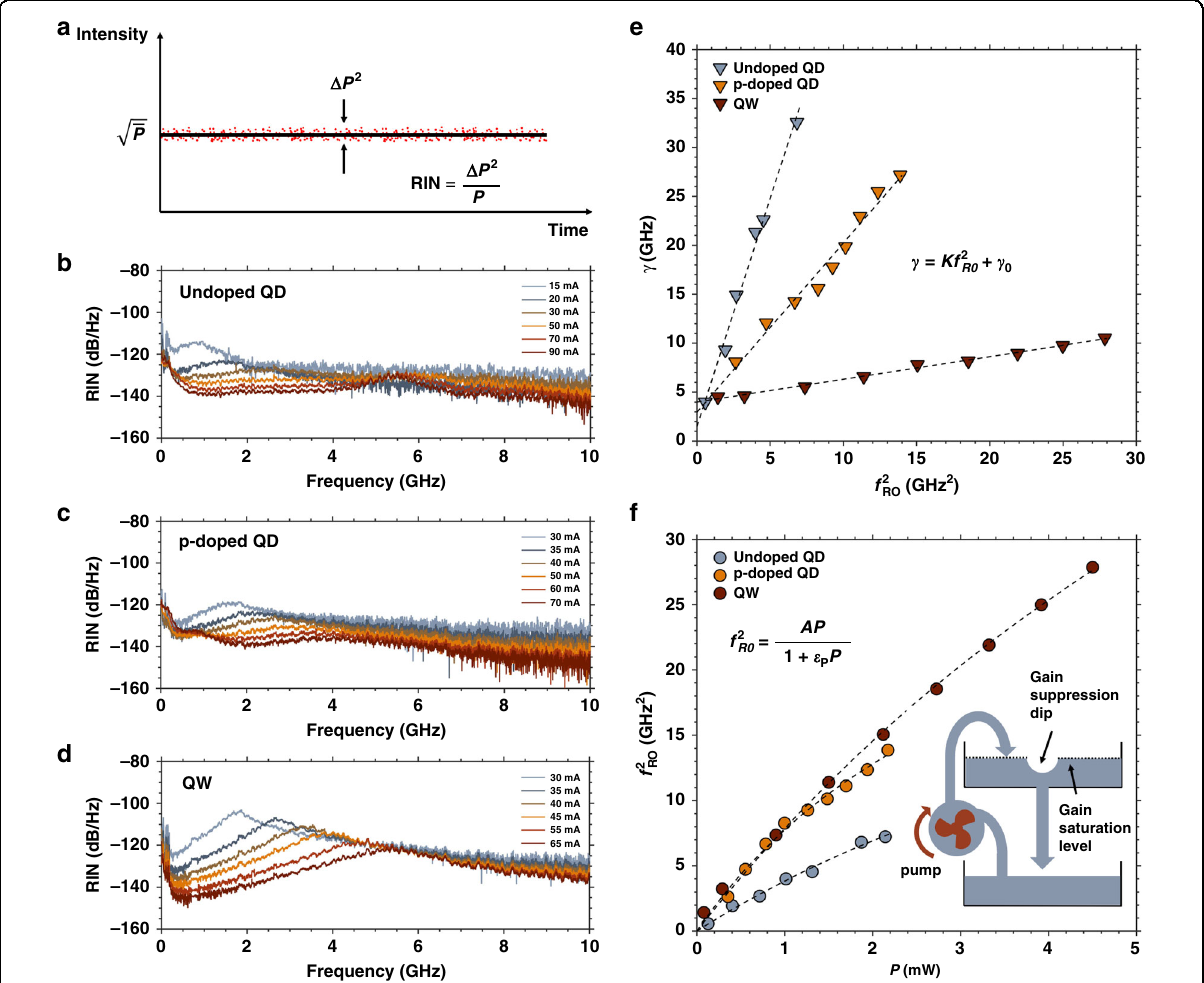
Fig. 8 Dynamic and relative intensity noise properties. ( a ) Schematic of the relative intensity noise (RIN) of semiconductor laser. RIN spectra up to 10 GHz for ( b ) undoped QD laser, ( c ) p-doped QD laser and ( d ) QW laser. ( e ) Damping factor ( γ ) as a function of the squared relaxation oscillation frequency ( f 2 ) for the undoped QD laser, p-doped QD laser and QW laser, respectively. ( f ) Squared relaxation oscillation frequency ( f 2 RO output power (P) for the undoped QD laser, p-doped QD laser and QW laser, respectively. The inset shows a hydraulic analogy to illustrate the gain compression in semiconductor